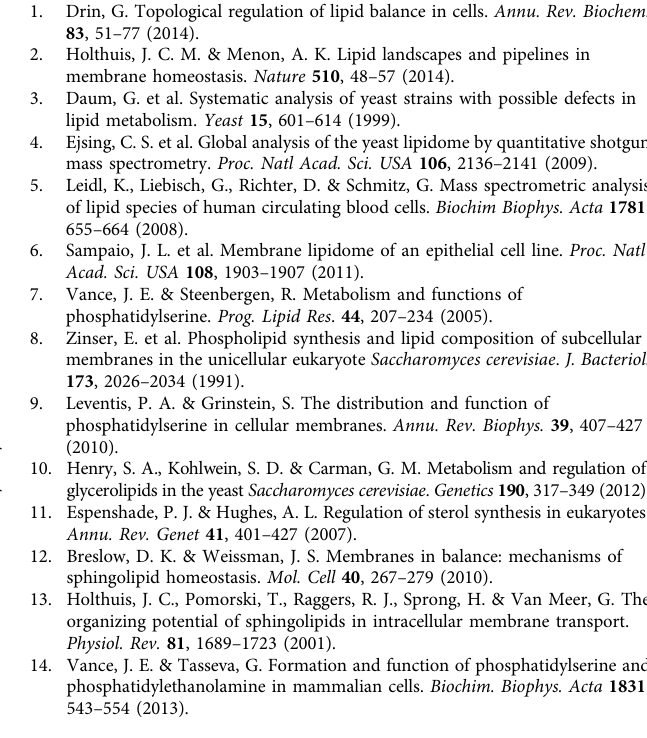
FigShare with the identi fi er https://doi.org/10.6084/m9. fi